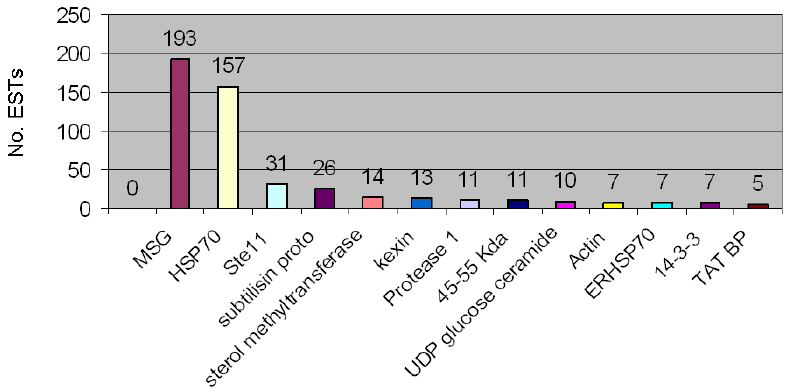
Figure 4. Distribution of P.cariniiESTs with significant similarities to known Pneumocystis genes. EST sequences with significant similarities to known P. carinii genes with BLASTx scores of E # 10 2